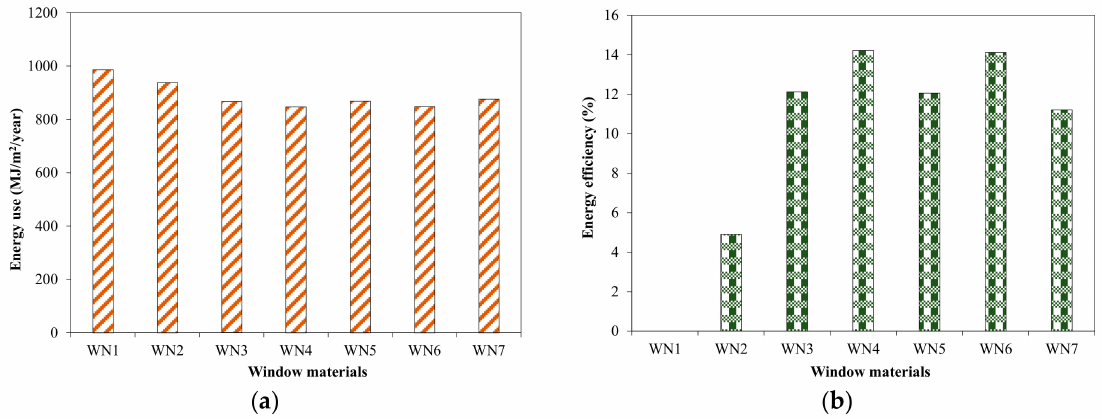
Figure 8. Effect of window material on energy use in tested office building. ( a ) Energy use; ( b ) Efficiency.